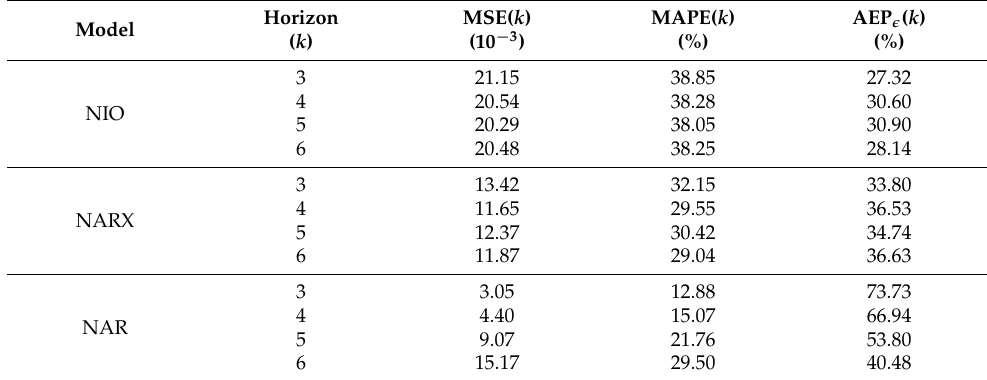
Table 4. Performance of NIO, NARX, and NAR models before implementing the pruning algorithm. Model